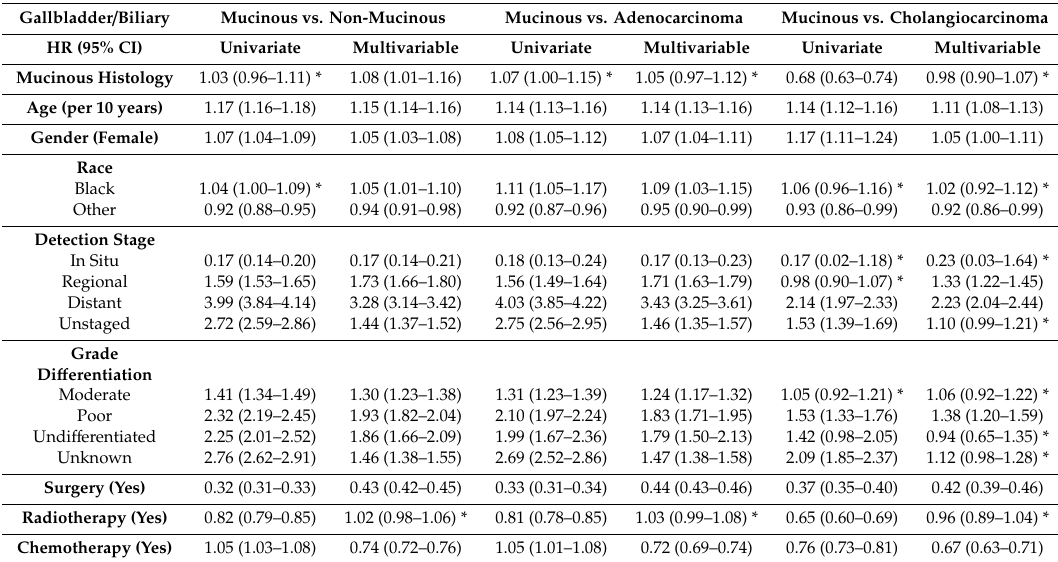
Table 16. Derived univariate and multivariable Cox-proportional hazard ratios (HR) of mortality for gallbladder / biliary cancers.